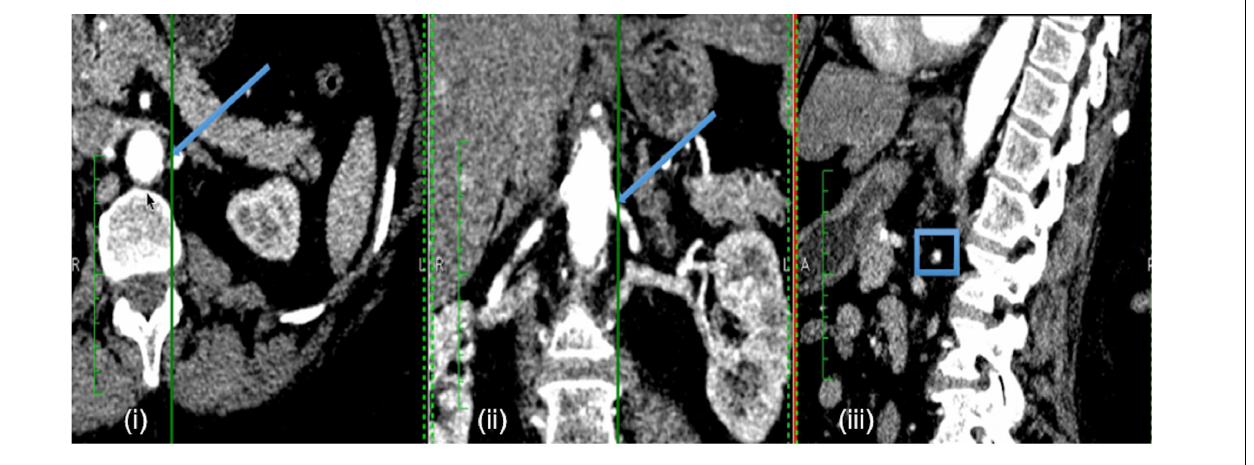
FIGURE 1 | Example of patient-specific CT images. Example CT images of each anatomical orientation for Patient 2: axial (i) , coronal (ii) , and sagittal (iii) . The arrows in the axial and coronal slices, and the box in the sagittal slice indicate the approximate location of the renal stenosis for the specific